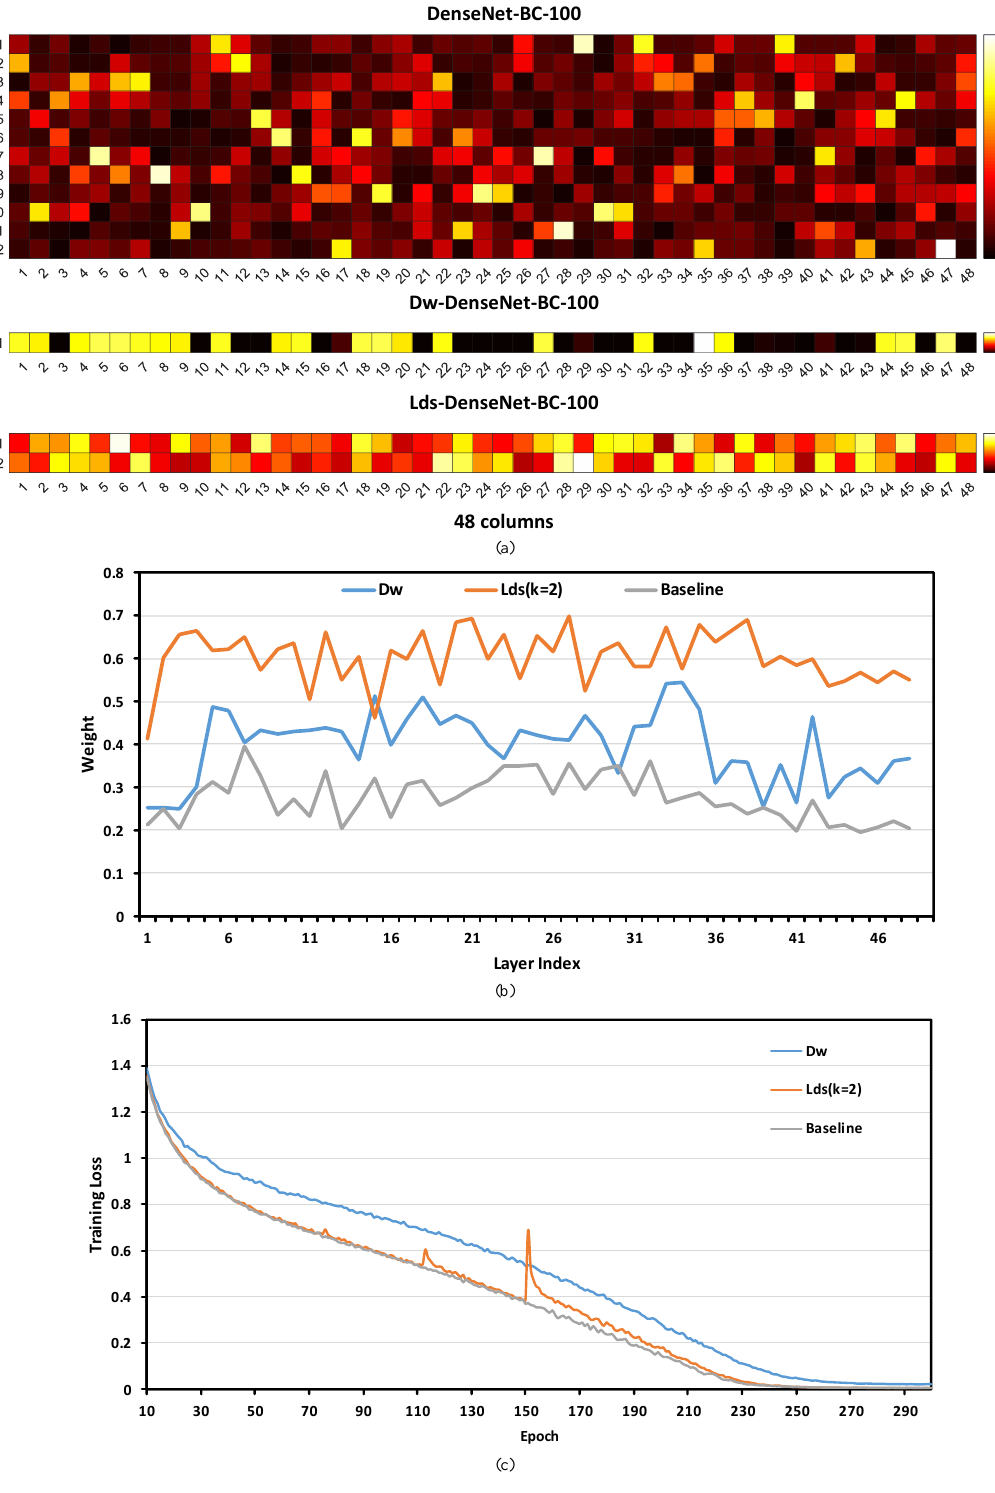
Figure 5. ( a ): Norm of weights of three models in Cifar 100. The block with darker color has less value of norm. The vertical and horizon axis represent the height and width of the weight matrix expect the Lds-DenseNet-BC-100 in which we arrange it in this way for alignment. ( b ) The curve between 48 3 × 3 convolutional layers in dense blocks and the average norm of weights for three models. ( c ) The curve of convergence speed for three